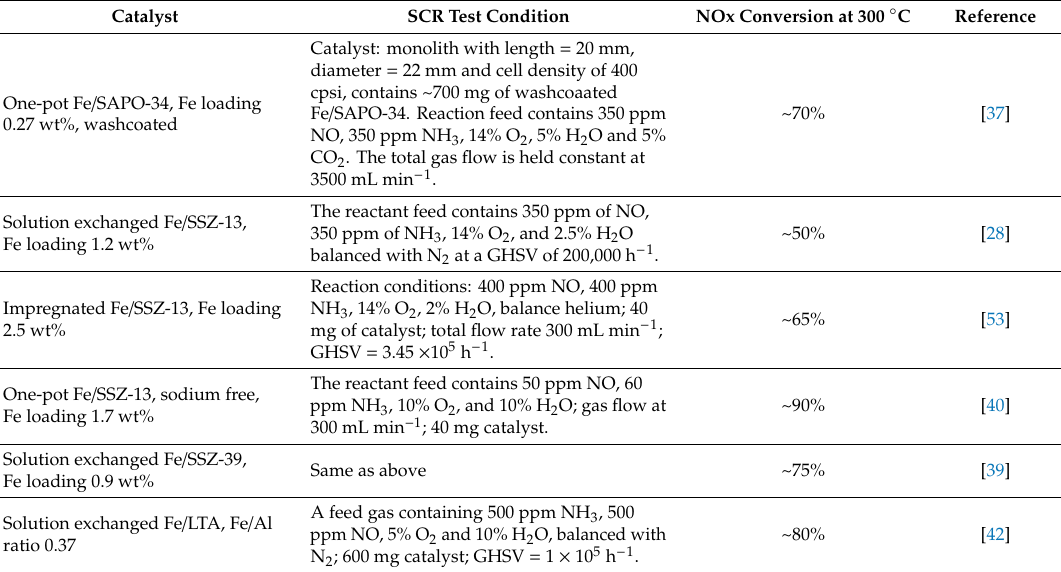
Table 1. SCR performance for selected small-pore Fe / zeolites at 300 ◦ C. 1